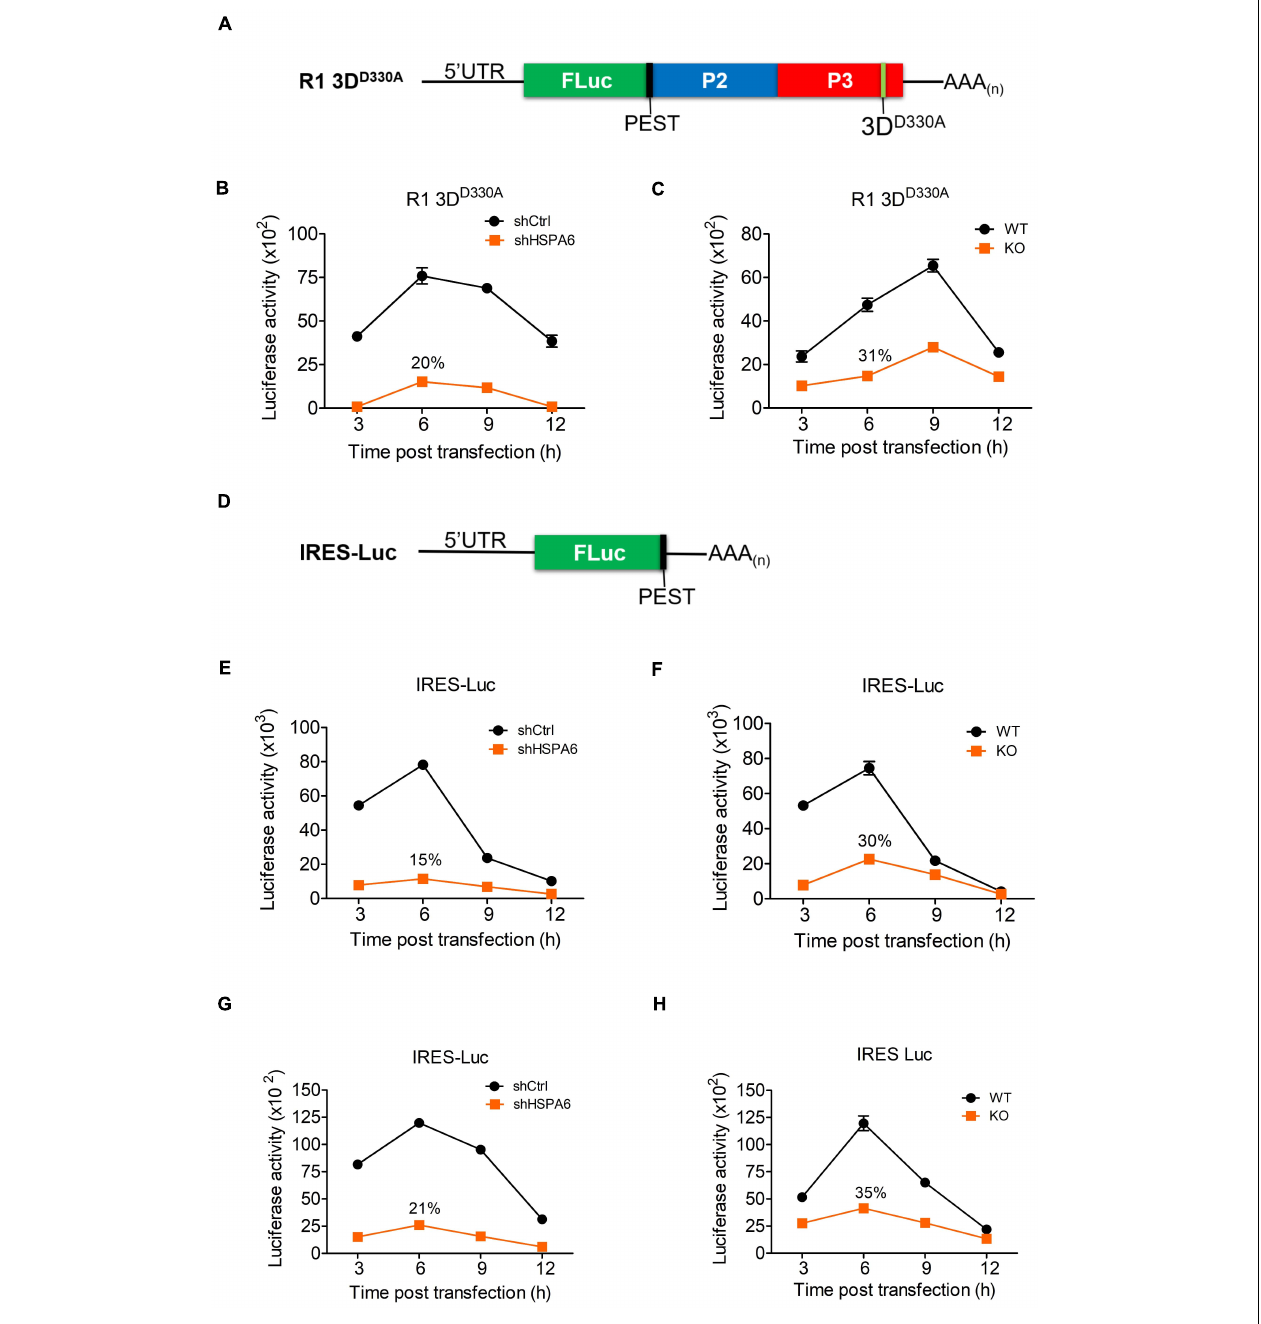
FIGURE 4 | HSPA6 upregulates EV-A71 IRES-meditated translation. (A) Schematic representation shows the mutant replicon R1 3D D 330 A . This replicon has a D330A mutation in the 3D pol region a PEST (Pro, Glu, Ser, and Thr) sequence, which caused rapid degradation of the luciferase protein. The in vitro transcribed RNA of R1 3D D 330 A was transfected into knockdown control (shCtrl) RD, shHSP6A RD, WT RD, and HSPA6 KO RD cells. Cells were harvested at 3, 6, 9, and 12 h post transfection for luciferase assay. Luciferase activity of reporter R1 3D D 330 A was compared between (B) shCtrl RD and shHSPA6 RD cells and between (C) WT RD and HSPA6 KO RD cells. (D) Schematic representation shows the reporter construct IRES-Luc, which contains no additional EV-A71 genes. (E,F) The in vitro transcribed RNA of IRES-Luc was transfected into RD cells 6 h post EV-A71 infection (MOI = 5). Cells were harvested at 3, 6, 9, and 12 h post transfection for luciferase assay. Luciferase activity was compared between (E) shCtrl RD and shHSP6A RD cells, and (F) WT RD and HSPA6 KO RD cells. (G,H) The in vitro transcribed RNA of IRES-Luc was transfected into RD cells without EV-A71 infection. Cells were harvested at 3, 6, 9, and 12 h post transfection for the luciferase activity assay. Luciferase activity was compared between (G) shCtrl RD RD and shHSPA6 RD cells and between (H) WT RD and HSPA6 KO RD cells. All measurements were normalized with RNA transfection efficiency. The data were presented as means ± SD ( n = 3) and analyzed with unpaired Student’s t -test. *** P < 0.001, ** P < 0.01, and * P <